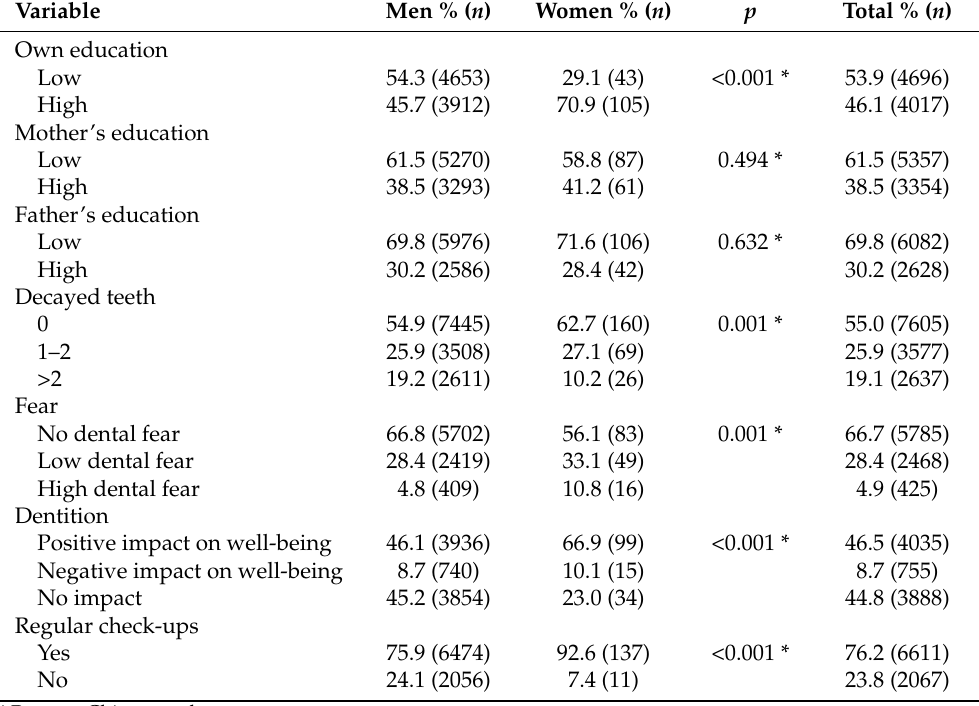
Table 1. Distribution of participants according to gender, their own and parents’ education, restora- tive treatment need, dental fear, effect of the dentition on self-reported well-being and regularity of